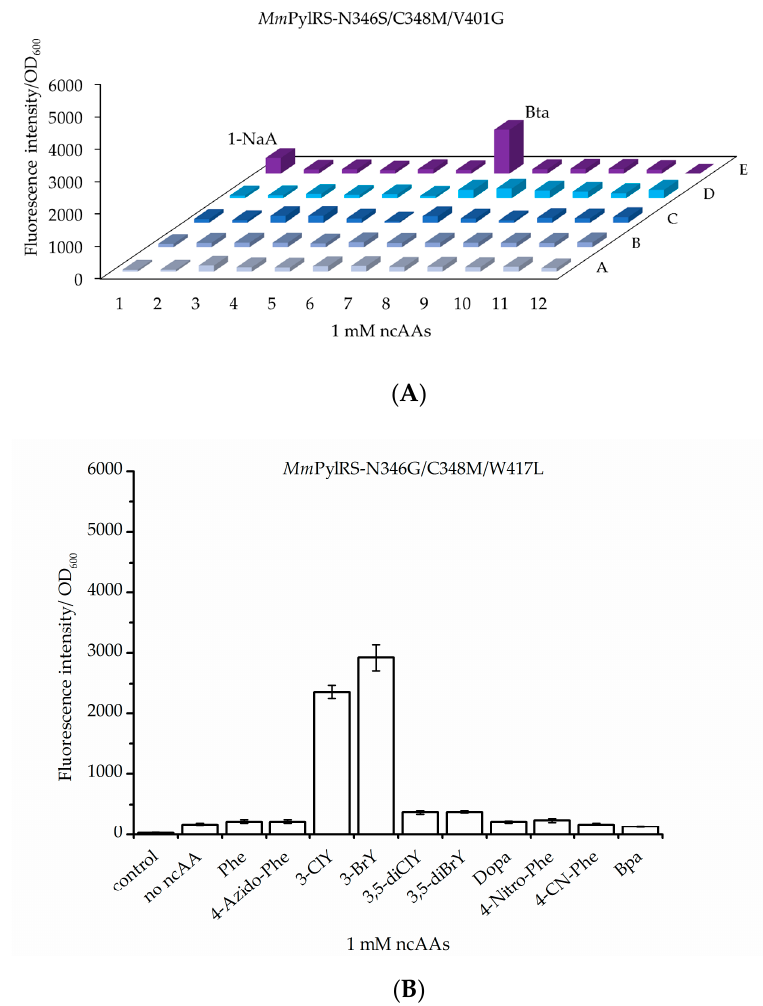
Figure 3. In vivo amber suppression capacities and analytics of ncAA incorporation at amber sites with two different Mm PylRS variants: ( A ) Mm PylRS–SMG and ( B ) Mm PylRS–GML. The library for ncAA incorporation was screened by monitoring sfGFP–R2TAG reporter fluorescence intensity. Details of the library screening with Mm PylRS variants and ncAAs in 96-well plates are given in Table S2 and S3. Each amino acid was supplied at a final concentration of 1 mM. (Control: no inducer and no ncAAs; no ncAAs: with inducer but without amino acids supplementation). Data in ( B ) is means ± SD ( n = 3).